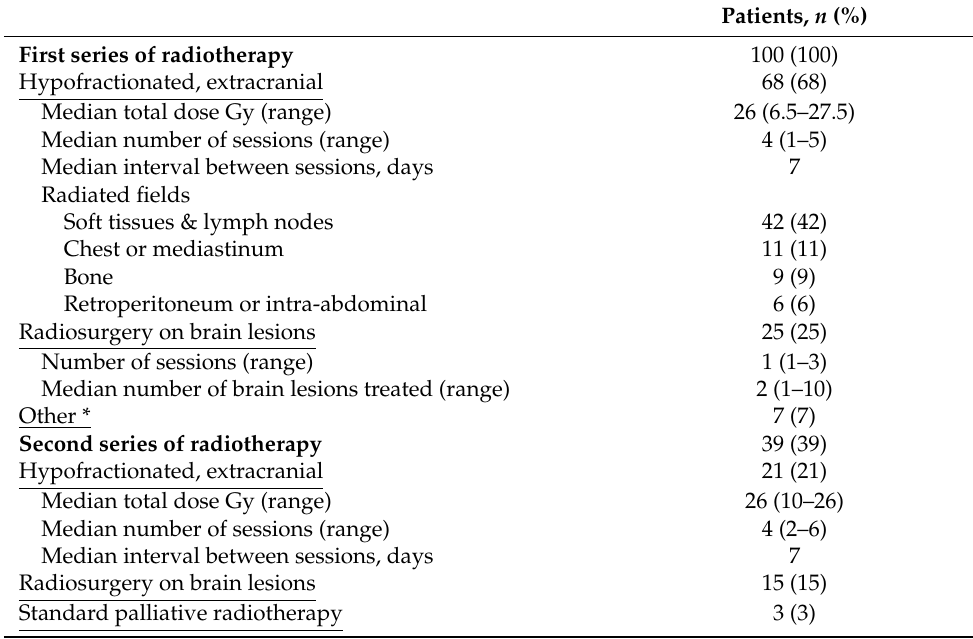
Table 2. Characteristics of the radiotherapy series in the 100 radiated and anti-PD-1-treated patients.